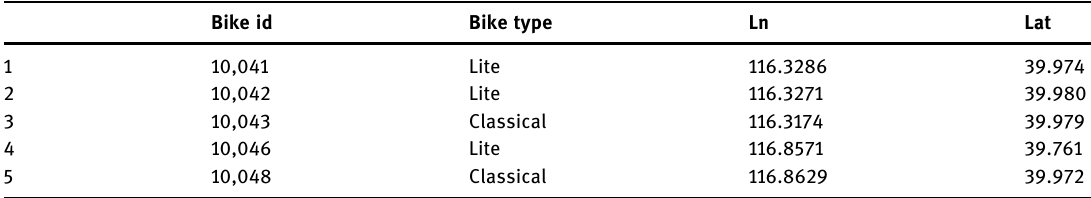
Table 1: Raw data of faulty